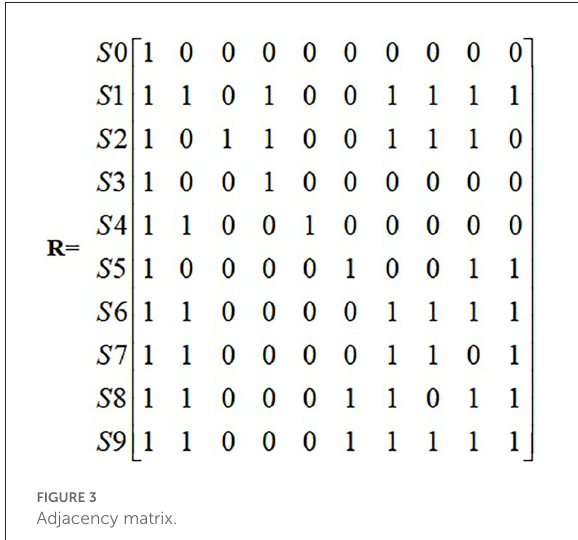
FIGURE3 Adjacency matrix.